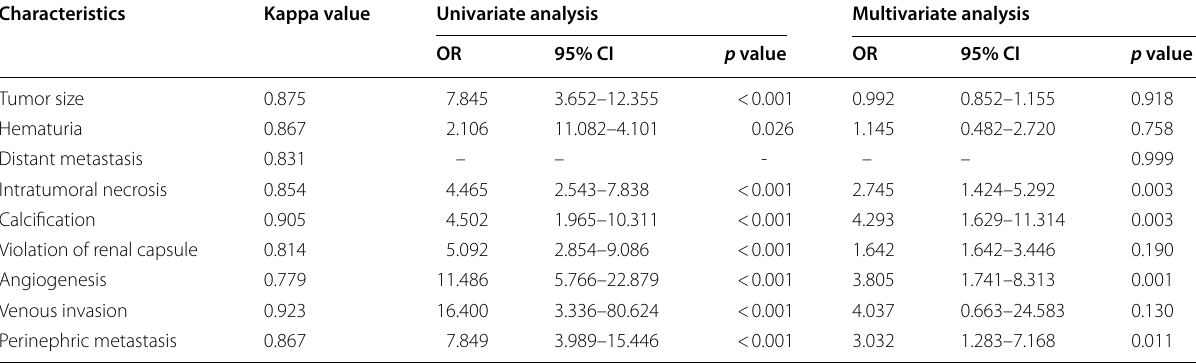
Table 4 Risk factors for WHO/ISUP nuclear grade of CCRCC according to univariate and multivariate analysis